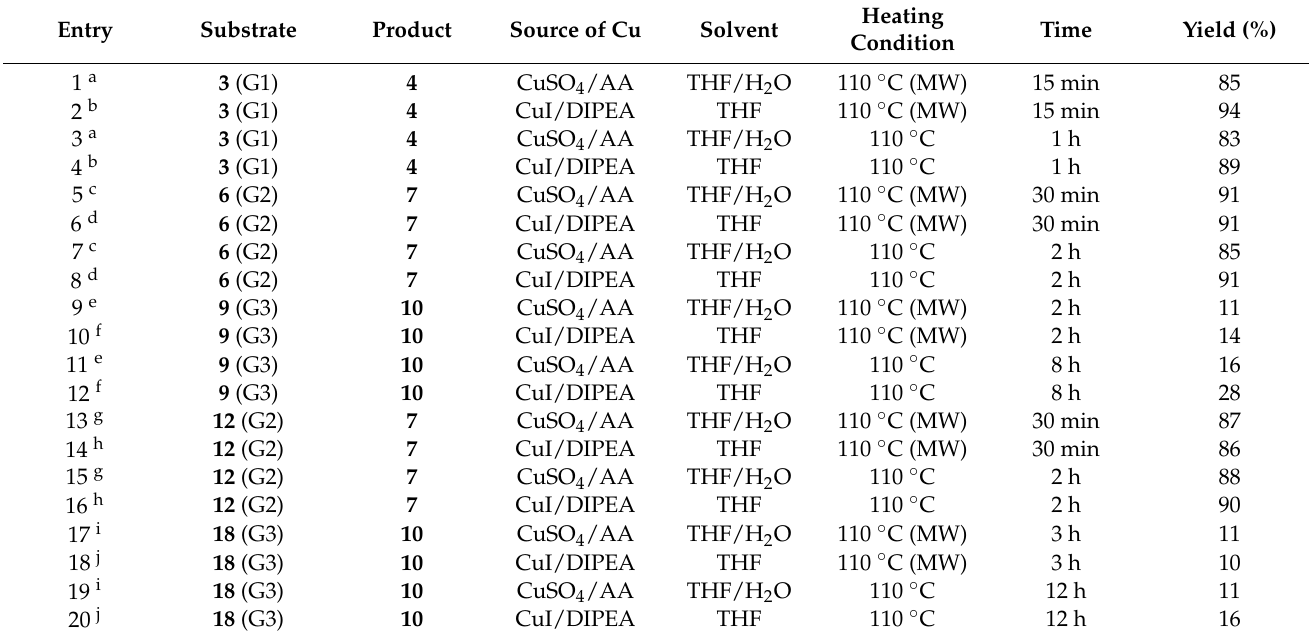
Table 1. Alkyne-azide cycloaddition reaction of dendrimers 3 , 6 , 9 , 12 , and 18 with BnN 3